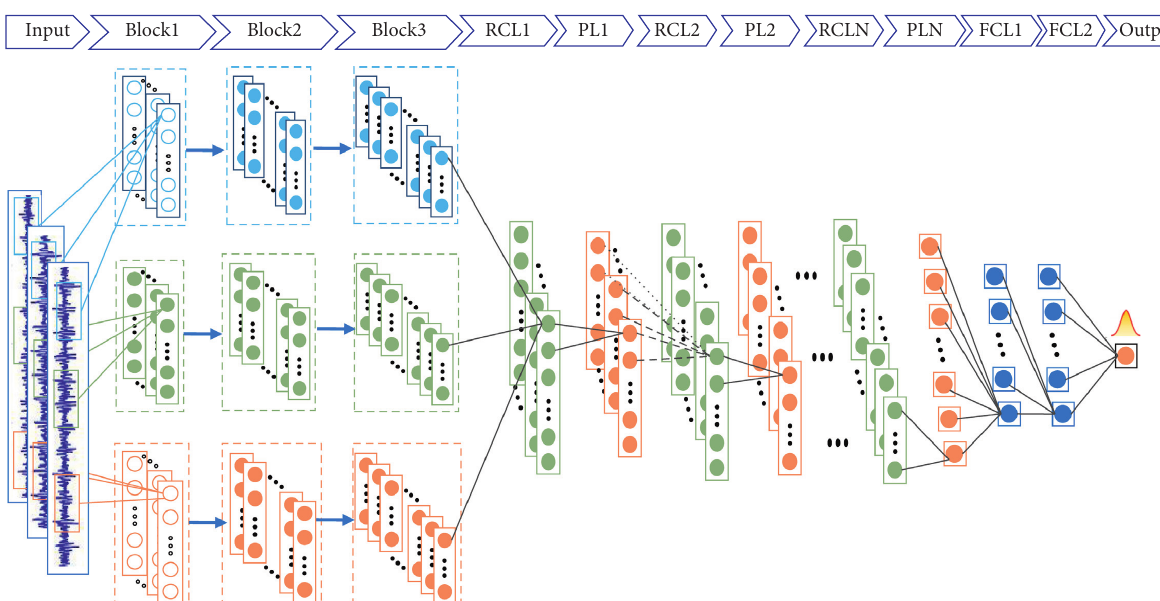
Figure 3: Architecture of parallel multichannel recurrent convolution